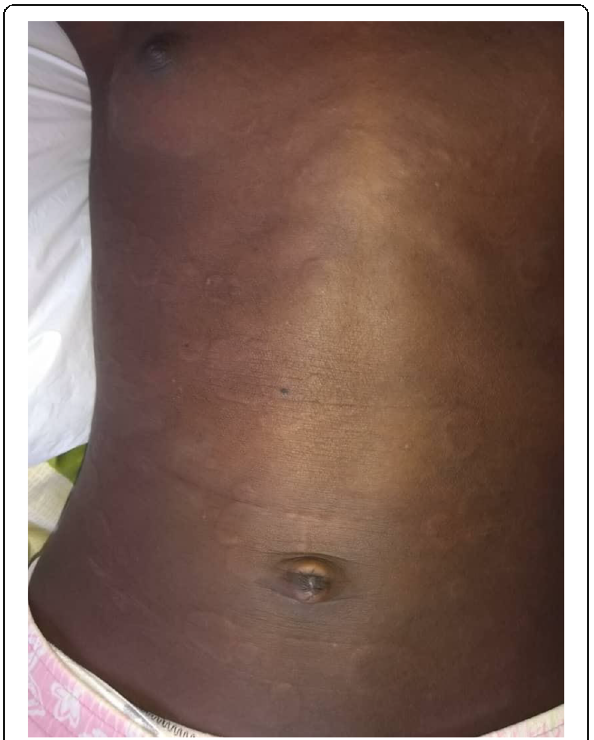
Fig. 2 Skin eruptions on the back showing papules, plaques, patches and polycyclic lesions with a reticular pattern having serpiginous and raised borders